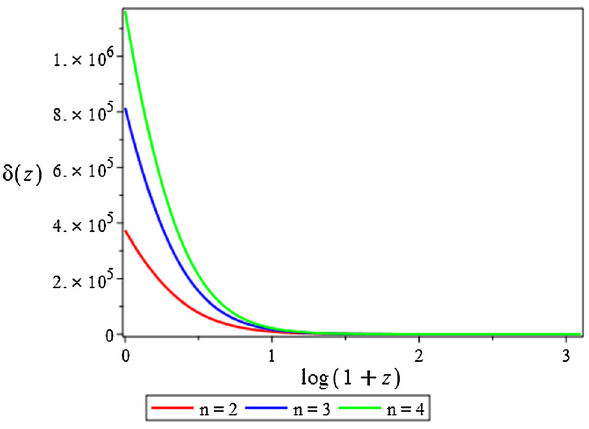
Fig. 17 δ( z ) versus z in long-wavelength mode for Eq. (115) for the values of n greater than one